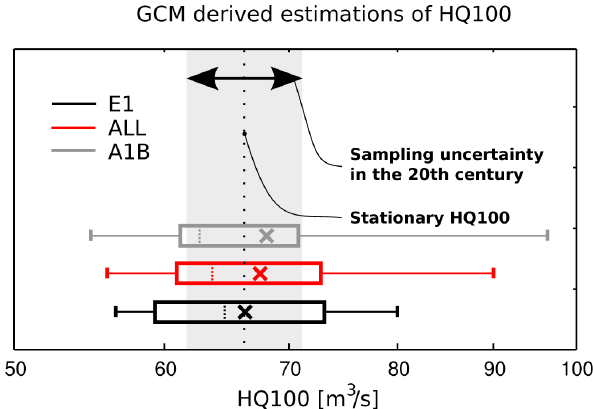
Figure 4. The results of the Monte Carlo simulation of HQ 100 for 2050 based on two different scenarios (A1B and E1) and the com- bination of all emission scenarios ALL for the 21st century. The 5th, 25th, 50th, 75th and 95th percentiles of the GCM ensemble are given by the boxplots. The ensemble mean is marked with a cross. The 90% sampling uncertainty of the 20th century 100-year flood is also shown in grey